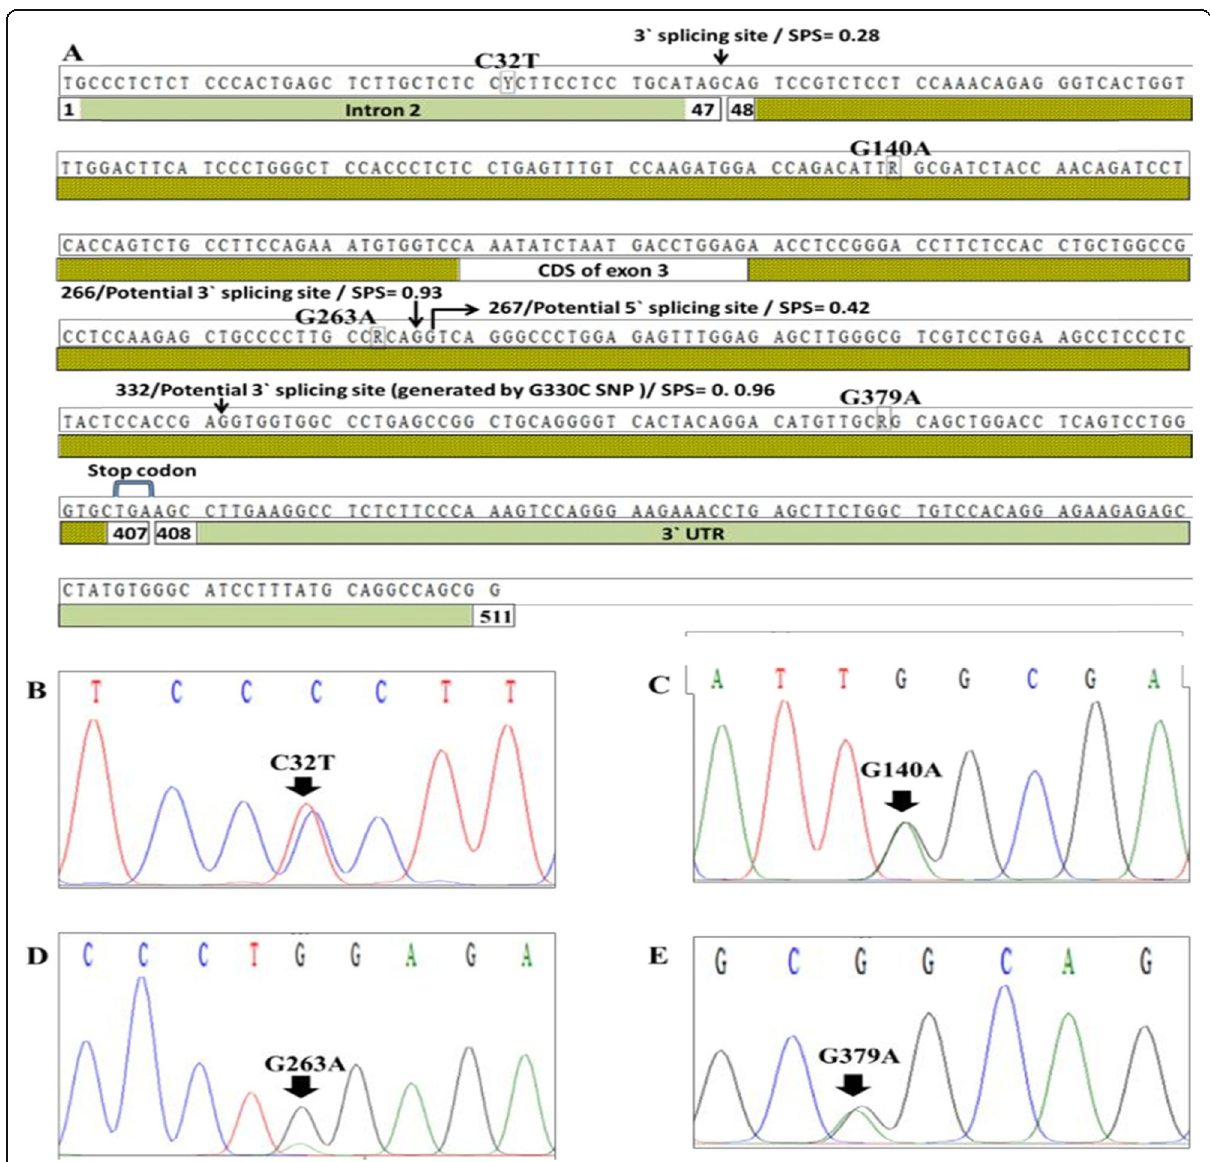
Fig. 2 a – e The nucleotide sequence and the detected SNPs in the Egyptian river buffalo LEP gene amplified fragment. SPS: SplicePort